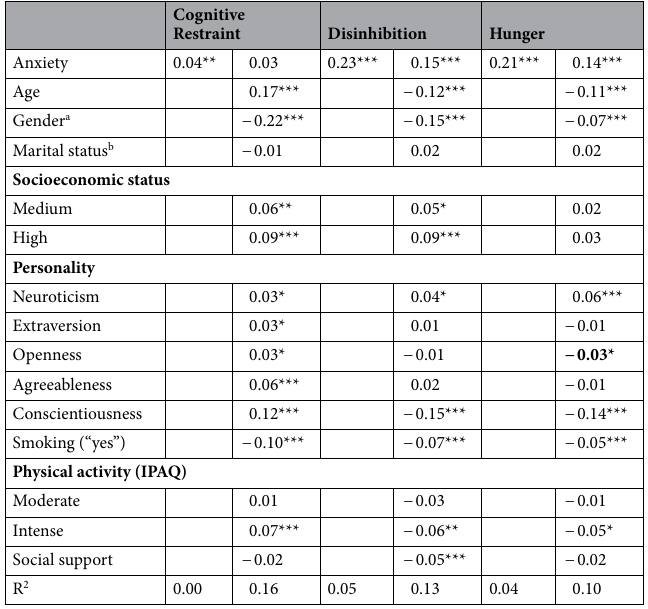
Table 2. Prediction of cognitive restraint, disinhibition, and hunger by anxiety (N = 5019; standardized regression coefficients). * p ≤ 0.05; + ** p ≤ 0.01; *** p ≤ 0.001. a Gender: 0 = female; 1 = male. b Marital status: 0 = married, living with partner; 1 = married and living separated, single, divorced,